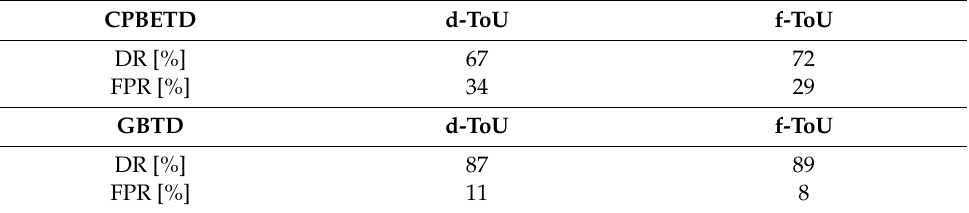
Table 2. Average theft detection performance of SVM-based CPBETD and XGBoost-based GBTD when using the dynamic ToU (d-ToU) and fixed ToU (f-ToU) window-based theft cases for an average of 1000 consumers (Existing